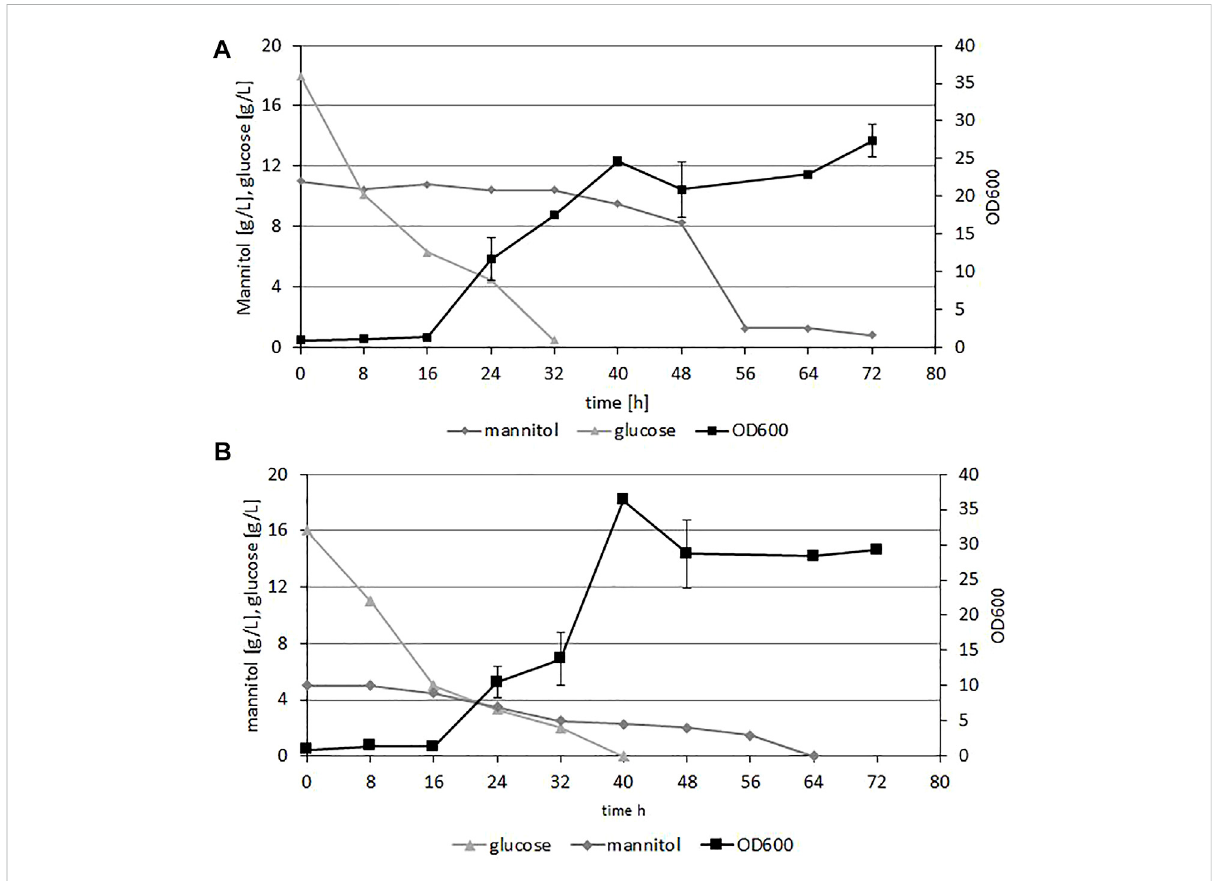
FIGURE 3 Time course of Y. lipolytica A101 growth (OD600) and fermentable sugar concentration during growth on F vesiculosus (A) and S. latissima (B) hydrolysatesinshake fl asksexperiment.Thestrainwasgrownin250 ml fl asksat28 ° C,with200 rpmshakingin50 mlmedium.ErrorbarsindicateSD from three biological